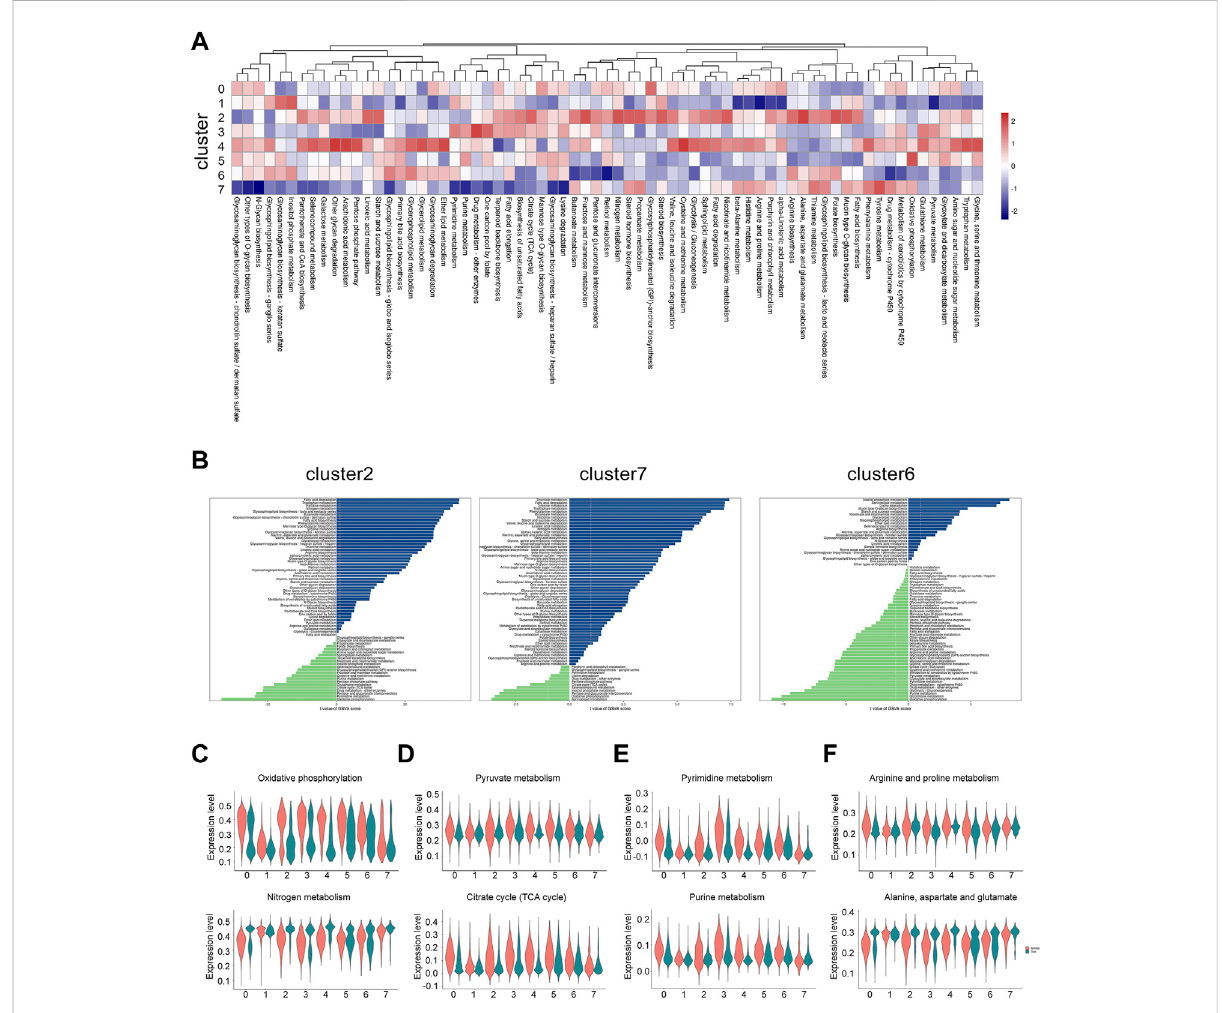
FIGURE 6 Themetabolicalterationinindividualcelltypesunderthinendometriumcondition. (A) Heatmapshowingthedifferentialmetabolicpathwaysin eachcelltype. (B) Barplotshowingthedramaticallychangedmetabolic pathwayswiththemetabolic genesets fromtheKEGGdatabaseinepithelial cells,ciliatedepithelialcells,andendothelialcells.Violinplotshowingtherepresentativemetabolicpathwaysinenergymetabolism (C) ,carbohydrate metabolism (D) , nucleotide metabolism (E) , and amino acid metabolism (F)